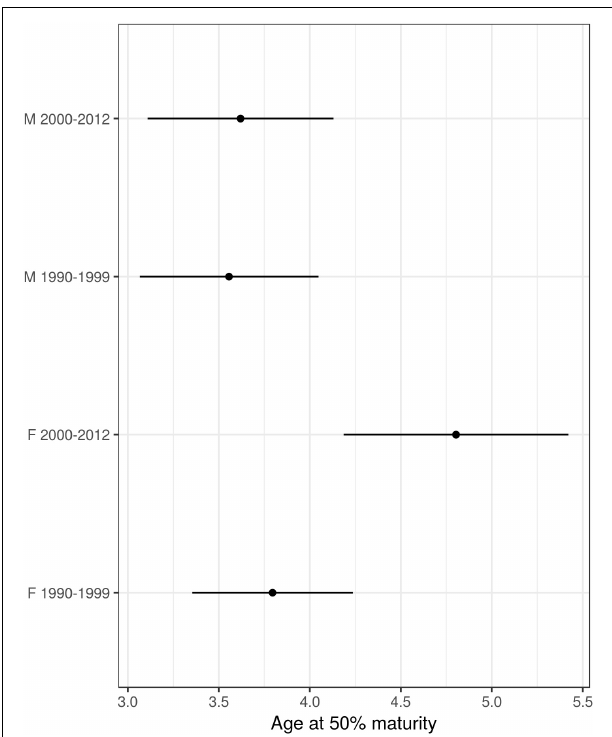
FIGURE 7 | Age at 50% maturity (years) estimates from the best fitting maturity model for age (years) (common age effect and separate intercepts by sex and time period). Points represent the mean value with horizontal lines denoting the 95% confidence